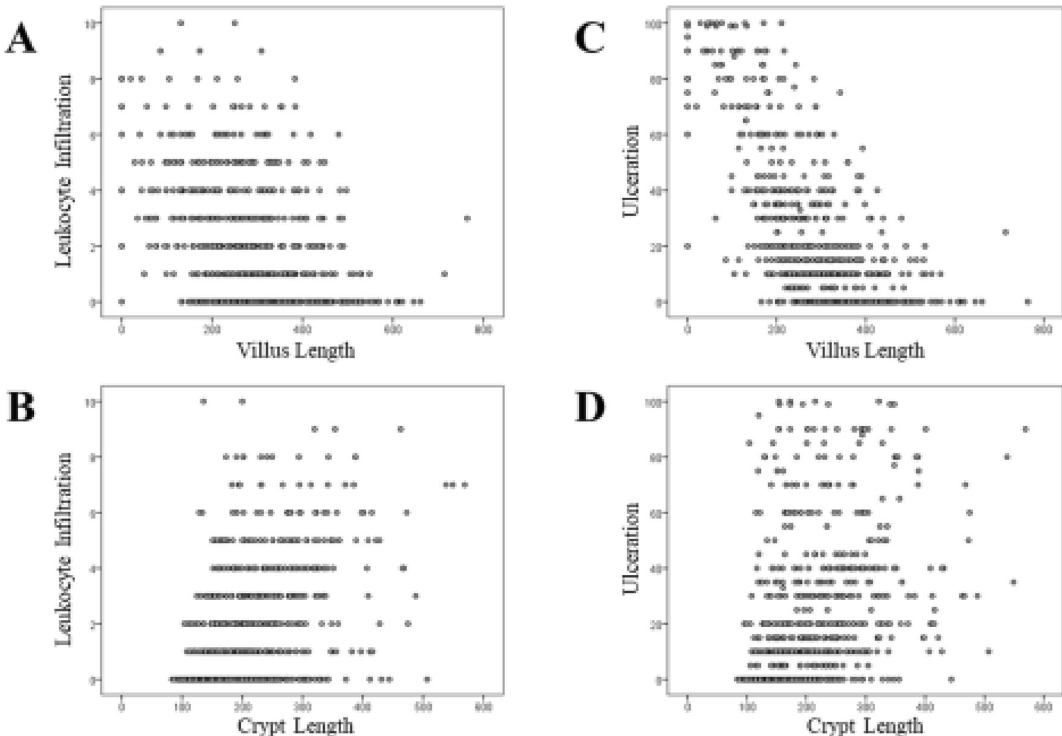
Figure 3. Correlation between findings of hPDAI and CMS. Neutrophil infiltration did not correlated with villus length [ A ; Spearman’s coefficient r = −0.367; p < 0.001], but did correlated with crypt length [ B ; r = 0.469; p < 0.001]. Ulceration showed an inverse correlation with villi length [ C ; r = −0.659; p < 0.001], but not with crypt length [ D ; r = 0.362; p < 0.001]. hPDAI-pouchitis disease activity index histology subscore; CMS-colonic metaplasia